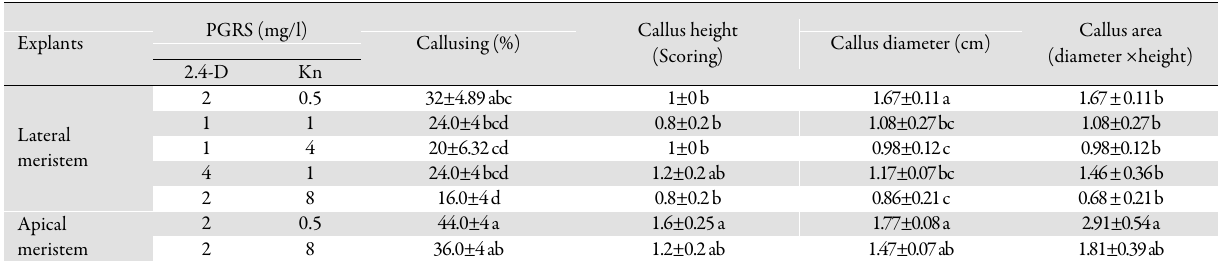
Table 1. Effects of 2.4-D and Kinetin concentrations on callusing, callus height, callus diameter and callus area of lateral and apical meristem as explants